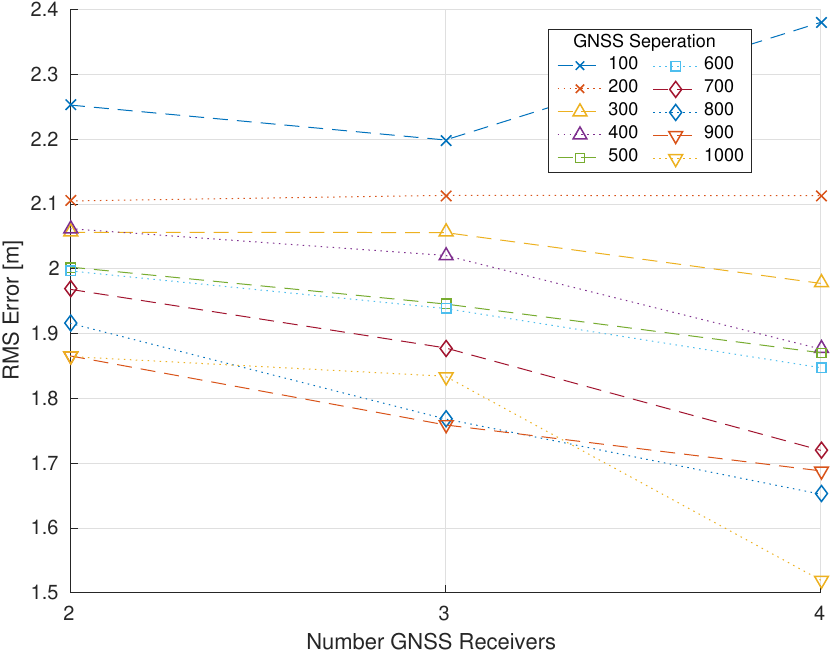
Figure 9. Magnitude of ice-relative vehicle x − y position error averaged over the 7.7 km ice relative mission as a function of number of GNSS receivers for each 10 GNSS baselines. Increasing the number of GNSS receivers on the ice generally results in reduced ice-relative vehicle position